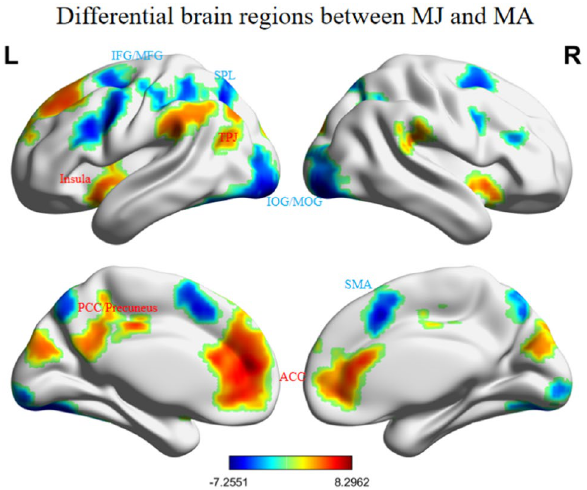
Figure 3. Differences between MJ and MA at a threshold of p < 0.05 (FWE-corrected). Images were plotted with the BrainNet Viewer. Warm (Cold) color indicates that MA elicited greater (weaker) activity than